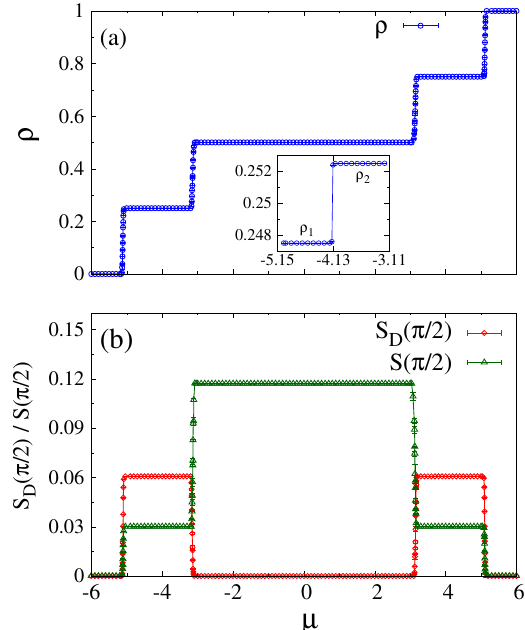
Figure 9: Variations of the order parameters: (a) HCB density ρ and (b) structure π ) and dimer structure factor S factor S ( 2 µ . Inset of (a): Splitting of ρ = 1 / 4 plateau under OBC. The measurements are done on a ladder with N = 200, where t